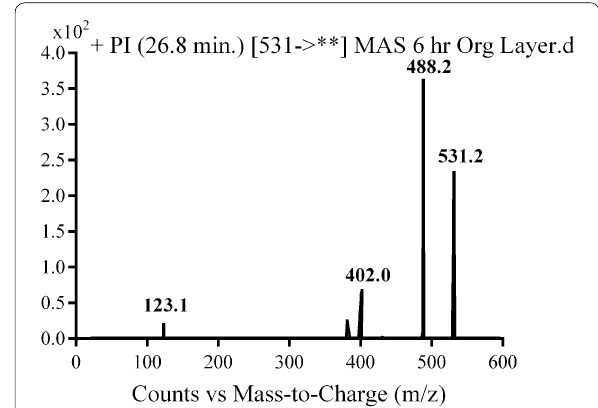
Fig. 9 PI mass spectrum of parent ion (M7) at m/z 529